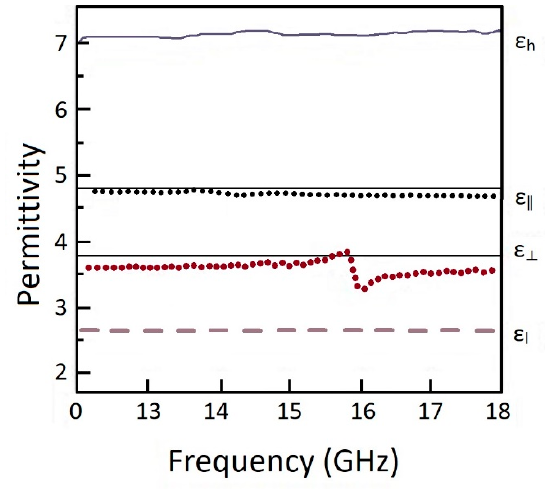
Figure 6. The test results of dielectric properties, where ε ∥ is the impinging microwaves parallel to the long direction of the stripes; ε ⊥ is the impinging microwaves parallel perpendicular to the long direction of the stripes; ε h is the material with high permittivity (Table 2); ε l is the material with low permittivity (Table 2) (Reprinted from Ref. [57], copyright (2016), with the kind permission of Else- vier).